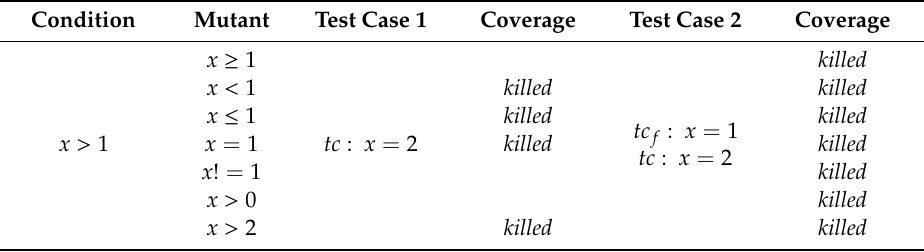
Table 2. Improving mutant coverage through failing test